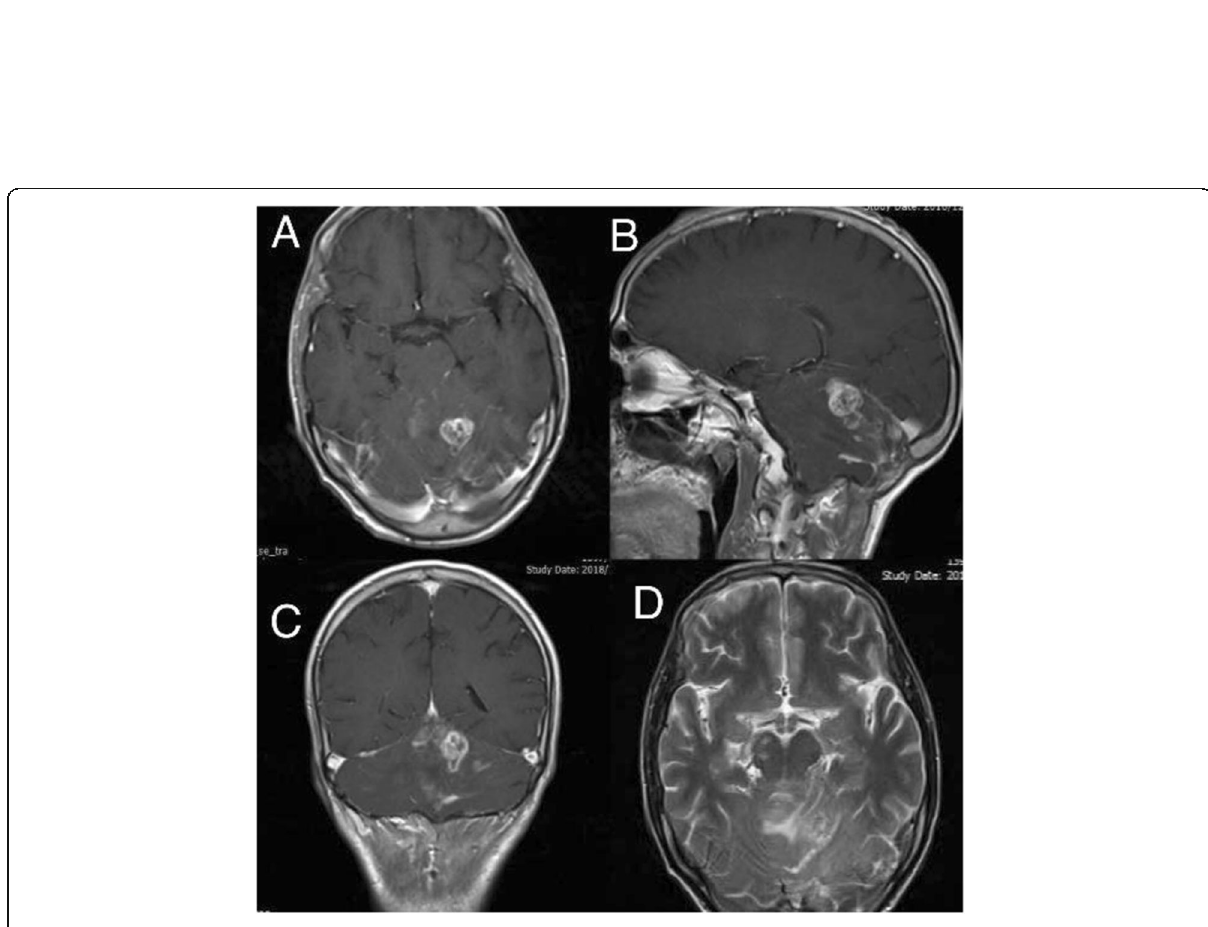
Fig. 5 The most recent T1-weighted MRI showing a gadolinium-enhanced mass within the left cerebellar hemisphere in axial, sagittal, and coronal views ( a – c , respectively). The mass was enhanced after gadolinium. d Axial T2-weighted most recent MR images with significant peripheral edema and compression on 4th